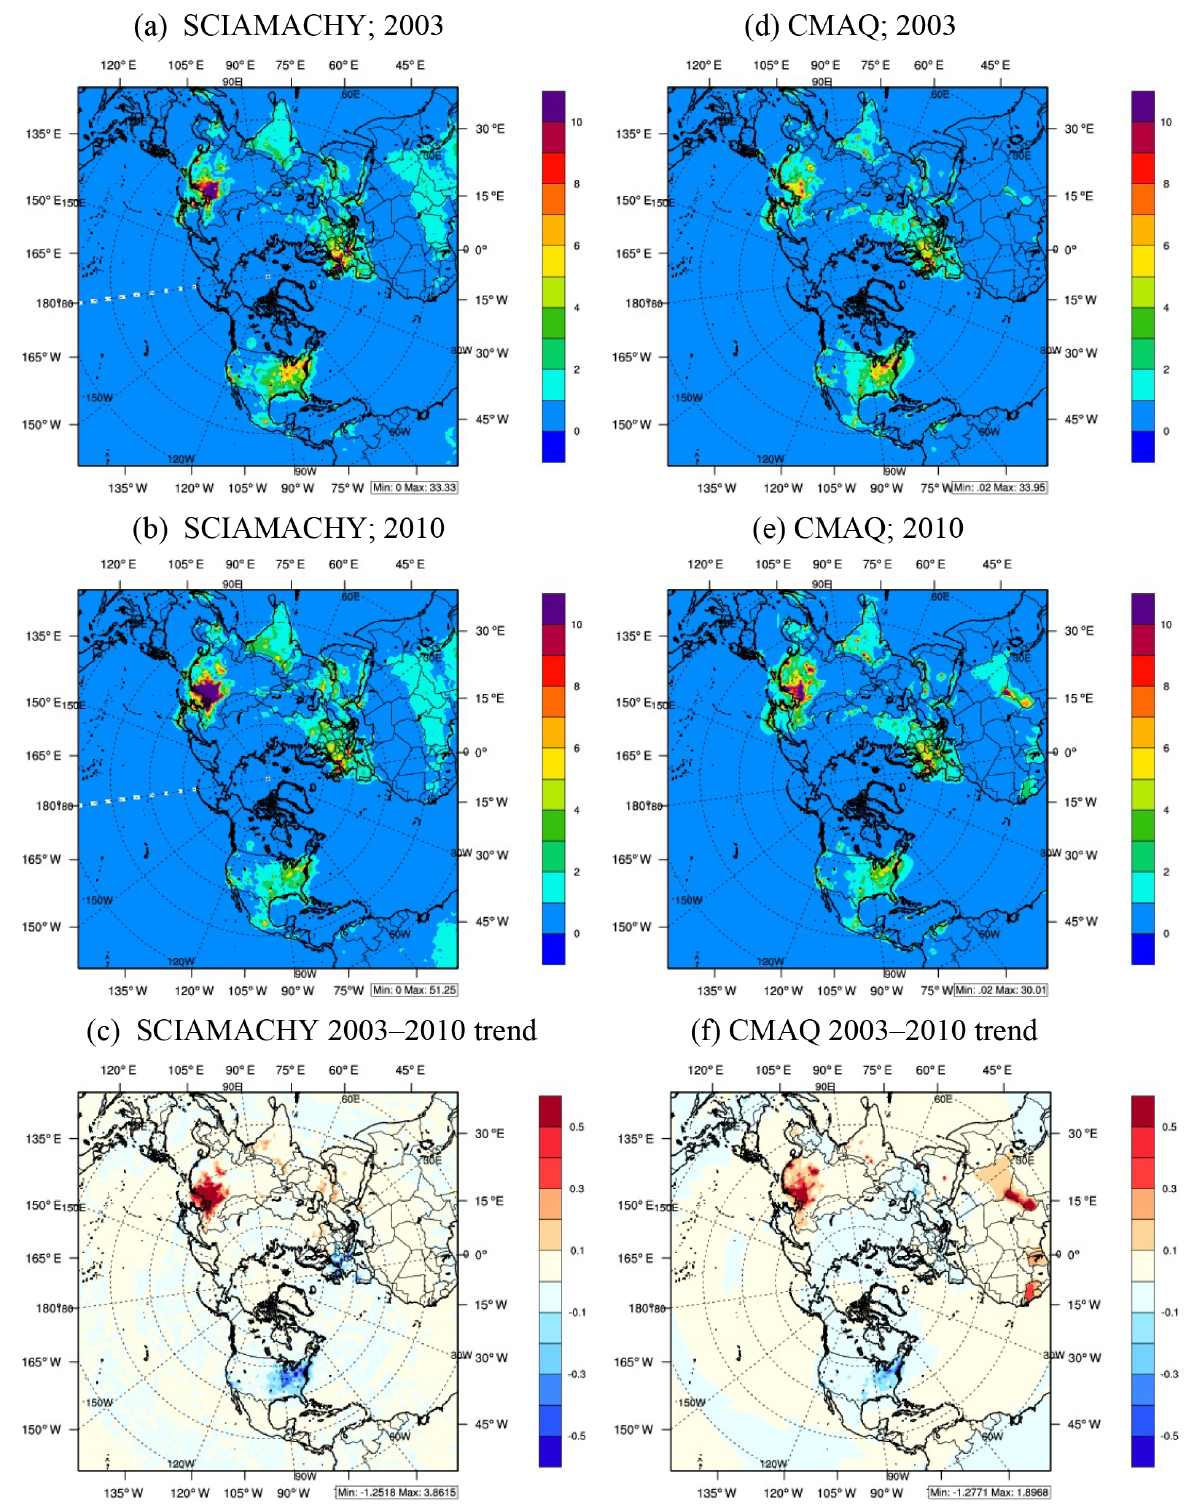
Figure 13. Comparison of observed (left) and model (right) changes in NO 2 vertical column density (VCD) across the Northern Hemisphere. Panel (a) shows 2003 SCIAMACHY NO 2 VCD; (b) 2010 SCIAMACHY NO 2 VCD; (c) SCIAMACHY NO 2 VCD trend; (d) 2003 CMAQ NO 2 VCD; (e) 2010 CMAQ NO 2 VCD; (f) CMAQ NO 2 VCD trend. VCD is units of 10 15 moleculescm − 2 , and VCD trend is in units of 10 15 moleculescm − 2 year − 1